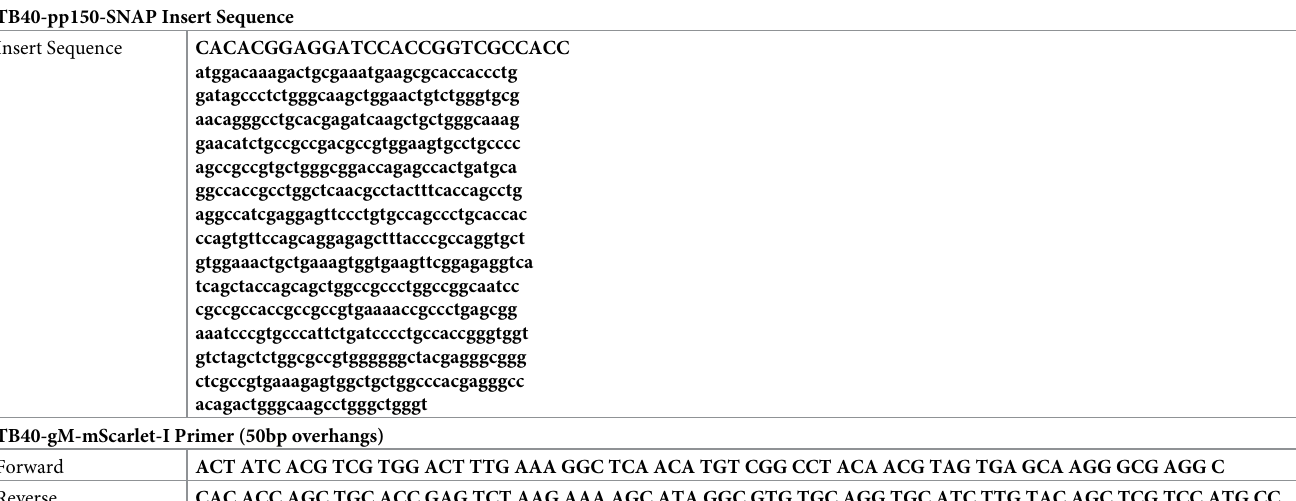
Table 1. Sequences for 2-Step BAC mutagenesis of HCMV-TB40-pp150-SNAP-gM-mScarlet-I. TB40-pp150-SNAP Insert Sequence Insert